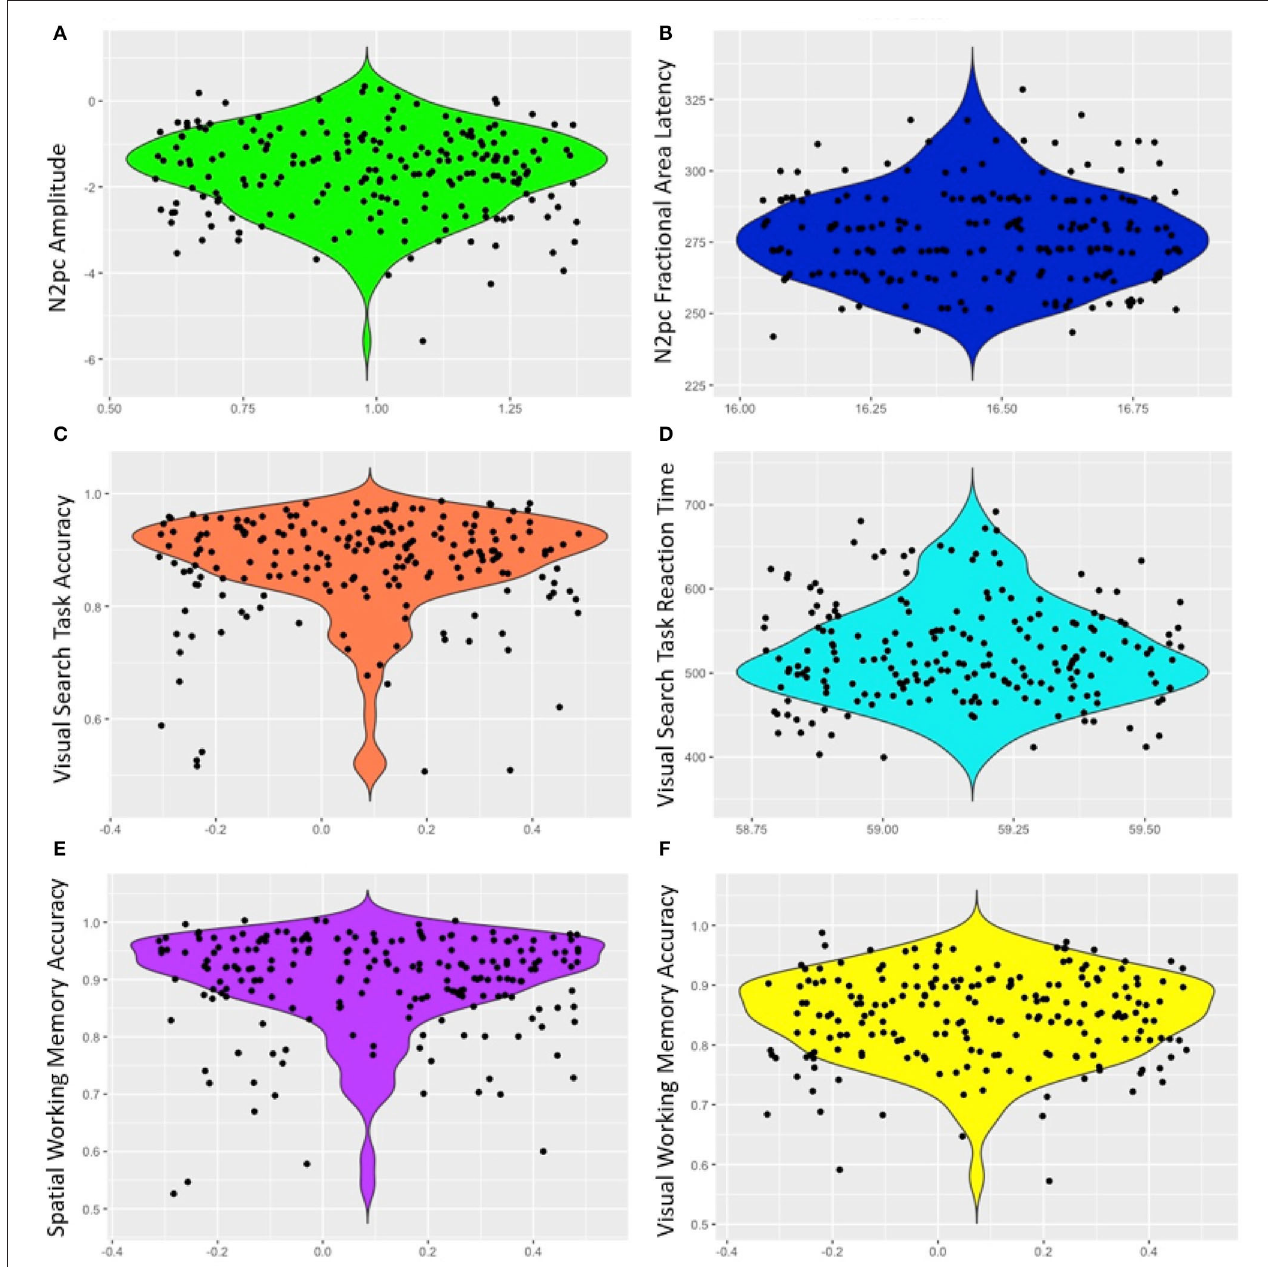
FIGURE 2 | Violin plots of ERP and behavioral measures (A) N2pc amplitude, (B) N2pc fractional area latency, (C) Visual search task accuracy, (D) Visual search task response time, (E) Spatial working memory accuracy, and (F) Visual working memory accuracy. Points are jittered randomly for better visualization on the x-axis.